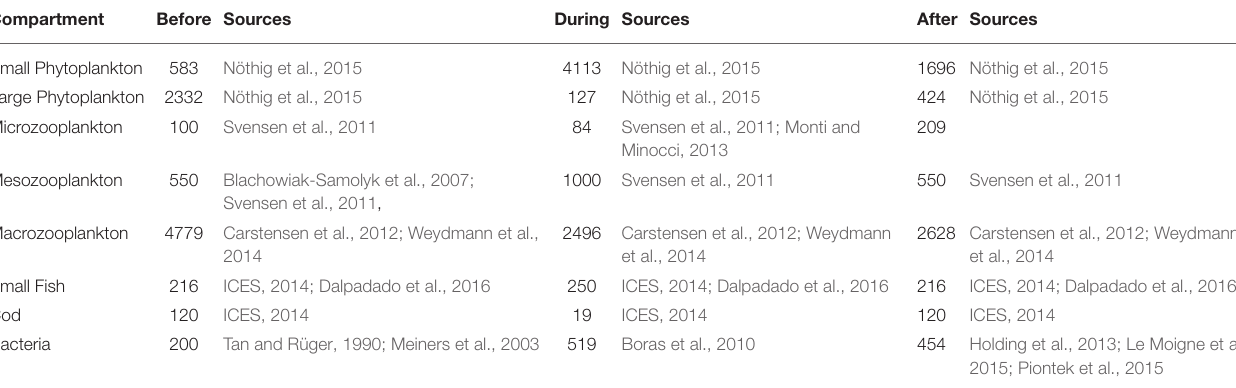
TABLE 3 | Biomass values (mg C m − 2 ) used for the formulation of constraint equations for the inverse analysis.